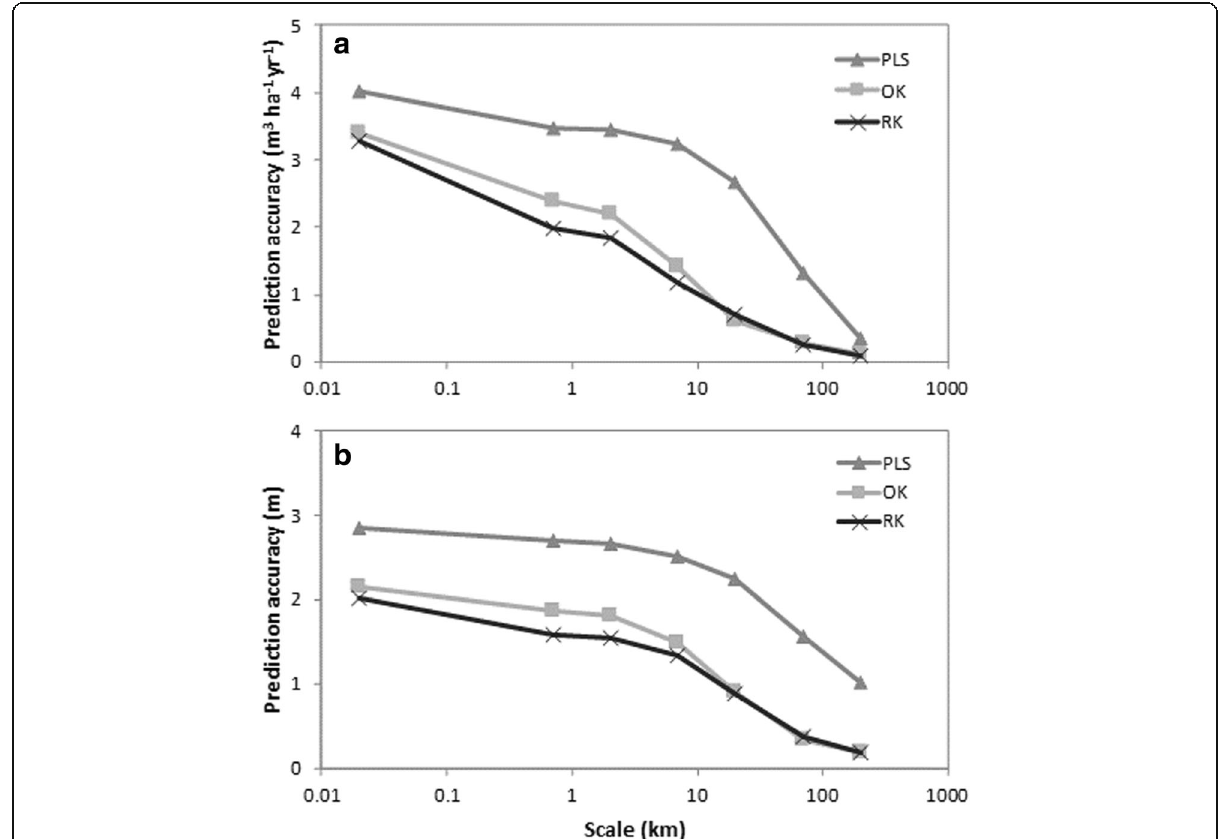
Fig. 4 Title: Accuracy of predictions across a range of scales. Accuracy (RMSE) of predicted ( a ) 300 Index and ( b ) Site Index across a range of scales from 0.02 to 200 km